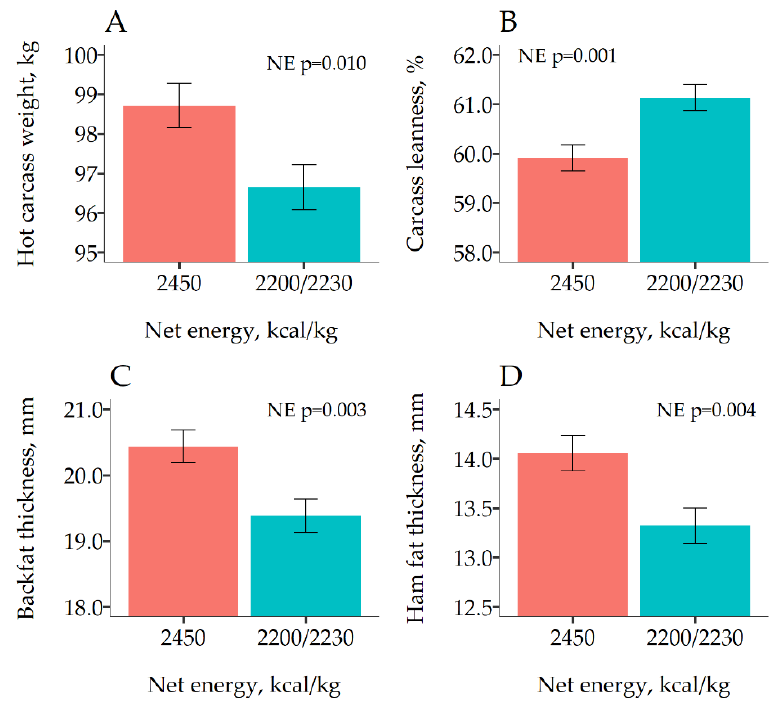
Figure 1. Least square means of the e ff ect of dietary net energy (NE) on carcass traits measured on the 380 first marketed pigs at day 86 of Experiment 2. For B, C and D, the response was adjusted using the carcass weight (HCW) as a linear predictor. Error bars represent the standard error of the mean.